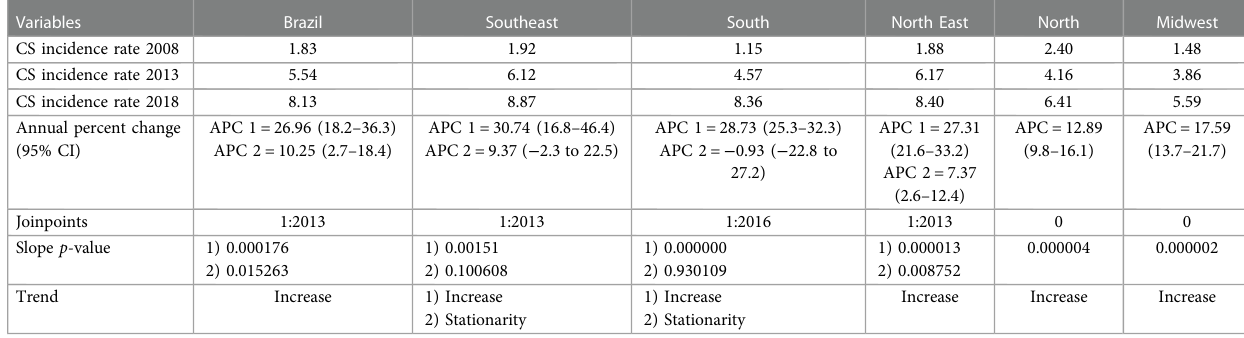
TABLE 2 Incidence rate trend of congenital syphilis in Brazil and macro-regions, 2008 – 2018. Variables Brazil Southeast South CS incidence rate